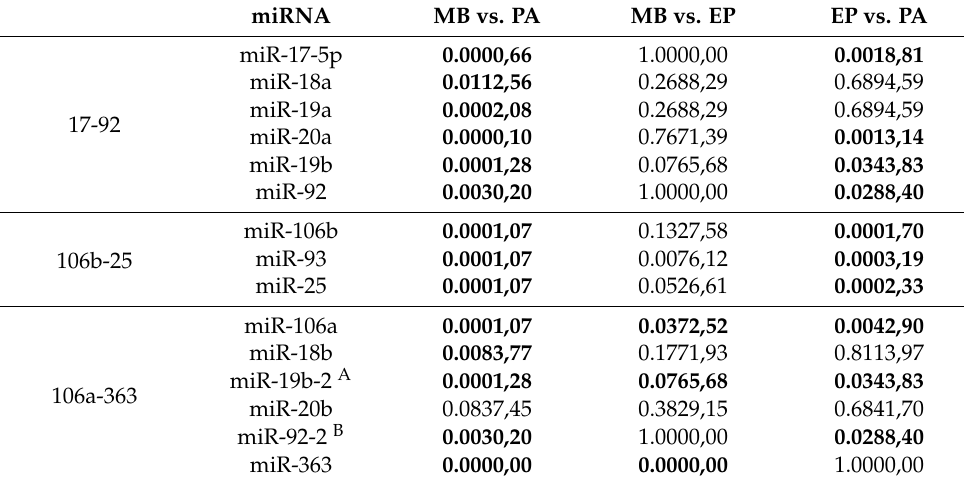
Table 2. p values determining the level of statistical significance in the expression of miRNAs from the miR-17-92, miR-106a-363, and miR-106b-25 clusters between the groups. If p value is less than 0.05 we report the result as statistically significant (indicated in bold). MB, medulloblastoma; EP, ependymoma; PA, pilocytic astrocytoma. miRNA MB vs. PA MB vs. EP EP vs. PA